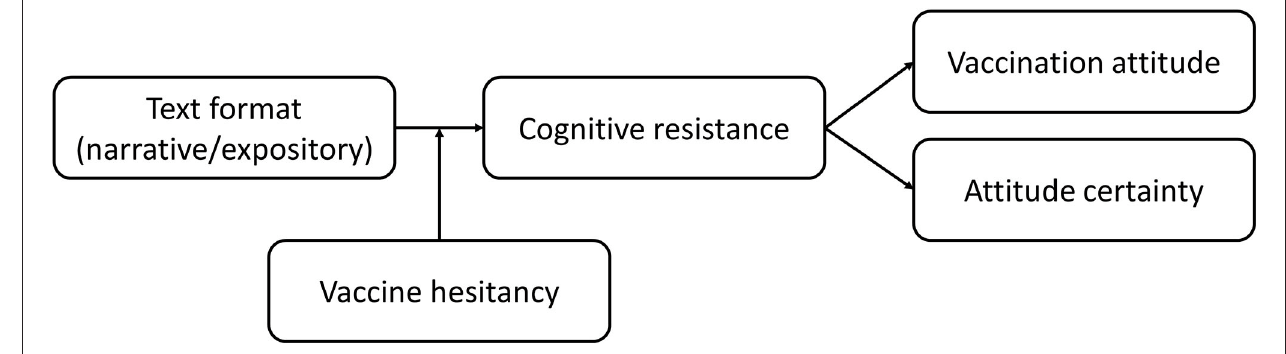
FIGURE 4 | Conceptual model.